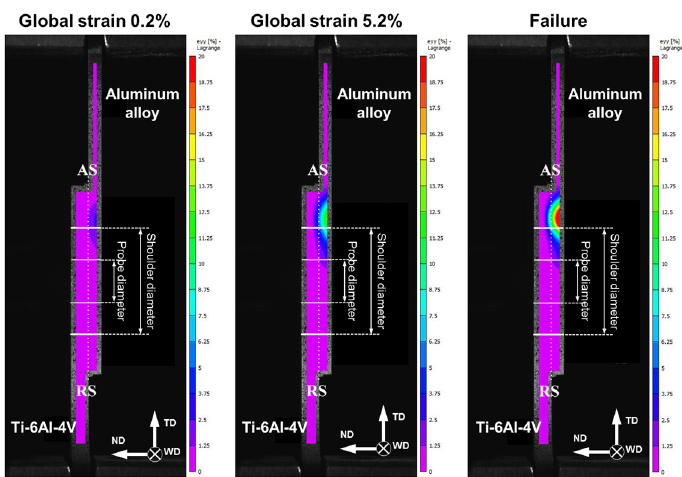
Figure 8. Typical distribution of longitudinal strains measured by digital image correlation technique in transverse cross section during lap-shear tests of welded joints as a function of global strain. Tensile direction is vertical. ND, TD, and WD are normal direction, transverse direction, and welding direction, respectively. RS and AS are retreating side and advancing side, respectively. Note: The tensile data were taken from the welded joint of AA6013 alloy produced at a welding speed of 12.7 mm/min.